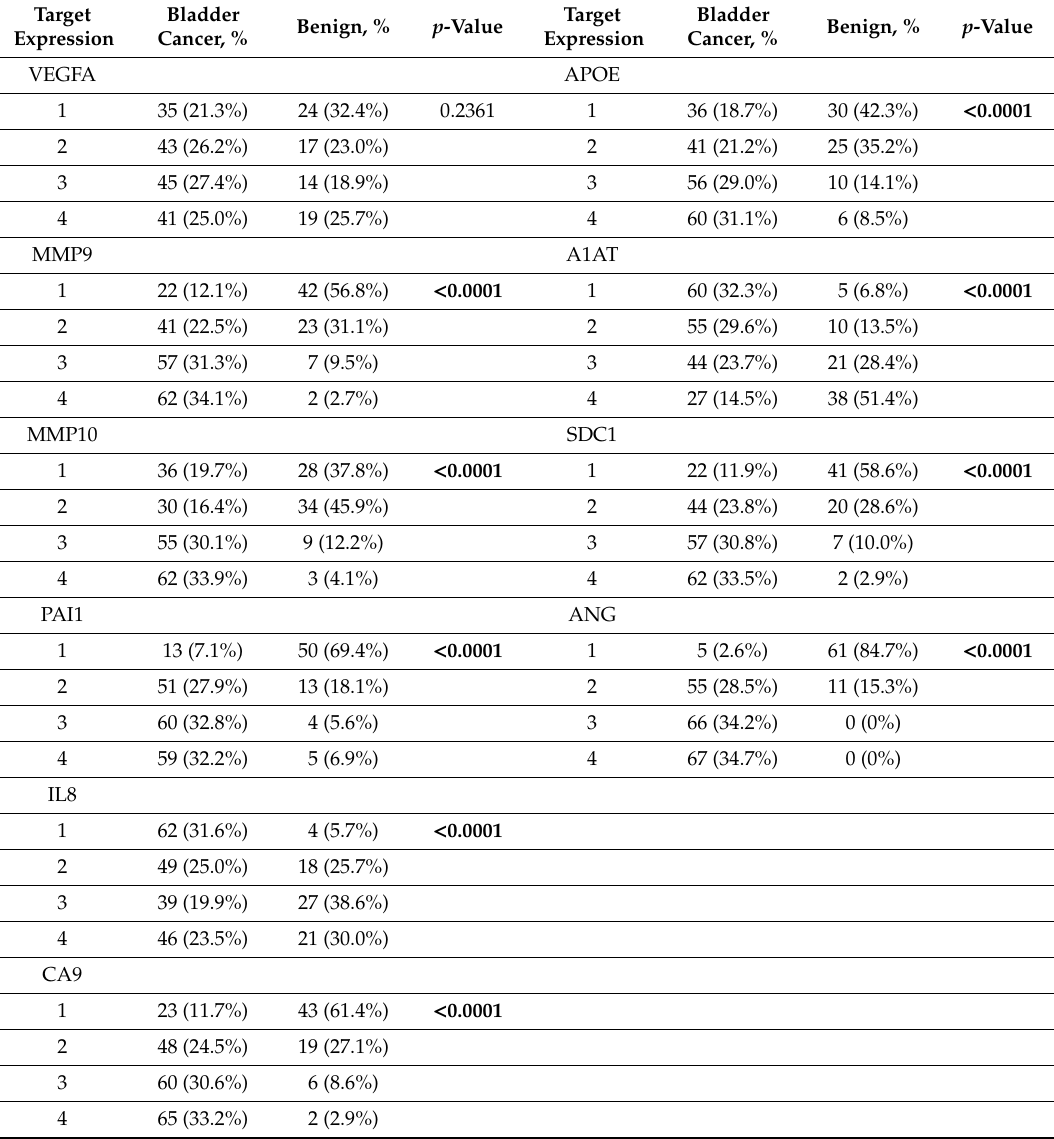
Table 2. Relationship between immunochemical features and disease